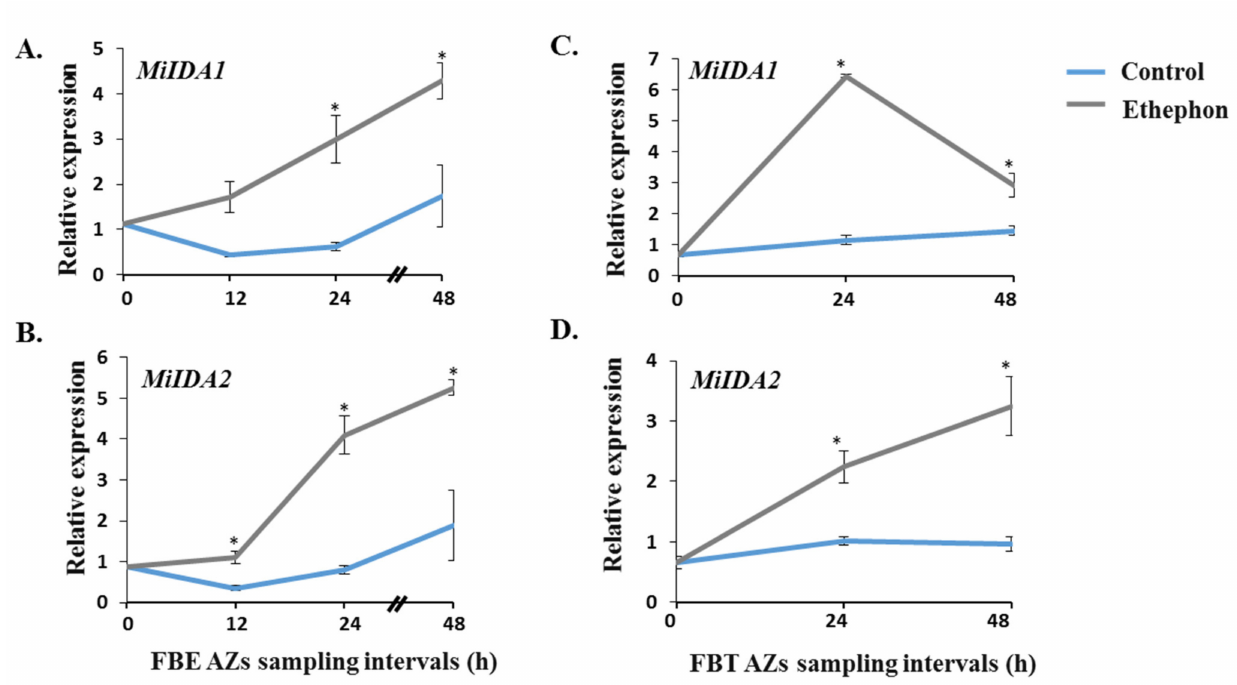
Figure 3. Effect of ethephon treatment on the relative expression of MiIDA1 and MiIDA2 genes in mango fruitlet AZs of FBE ( A , B ) and FBT ( C , D ). Analysis of qRT-PCR was performed using cDNA prepared from total RNA extracted from FBE or FBT AZ tissues as detailed in Materials and Methods. Values represent relative expression levels normalized to that of the endogenous reference gene, MiGAPDH . For each group and time point, the data are presented as the means ± SE of three independent biological replicates, and two technical replicates. Asterisks (*) denote significant differences between ethephon-treated and control AZ samples at each sampling point ( p ≤